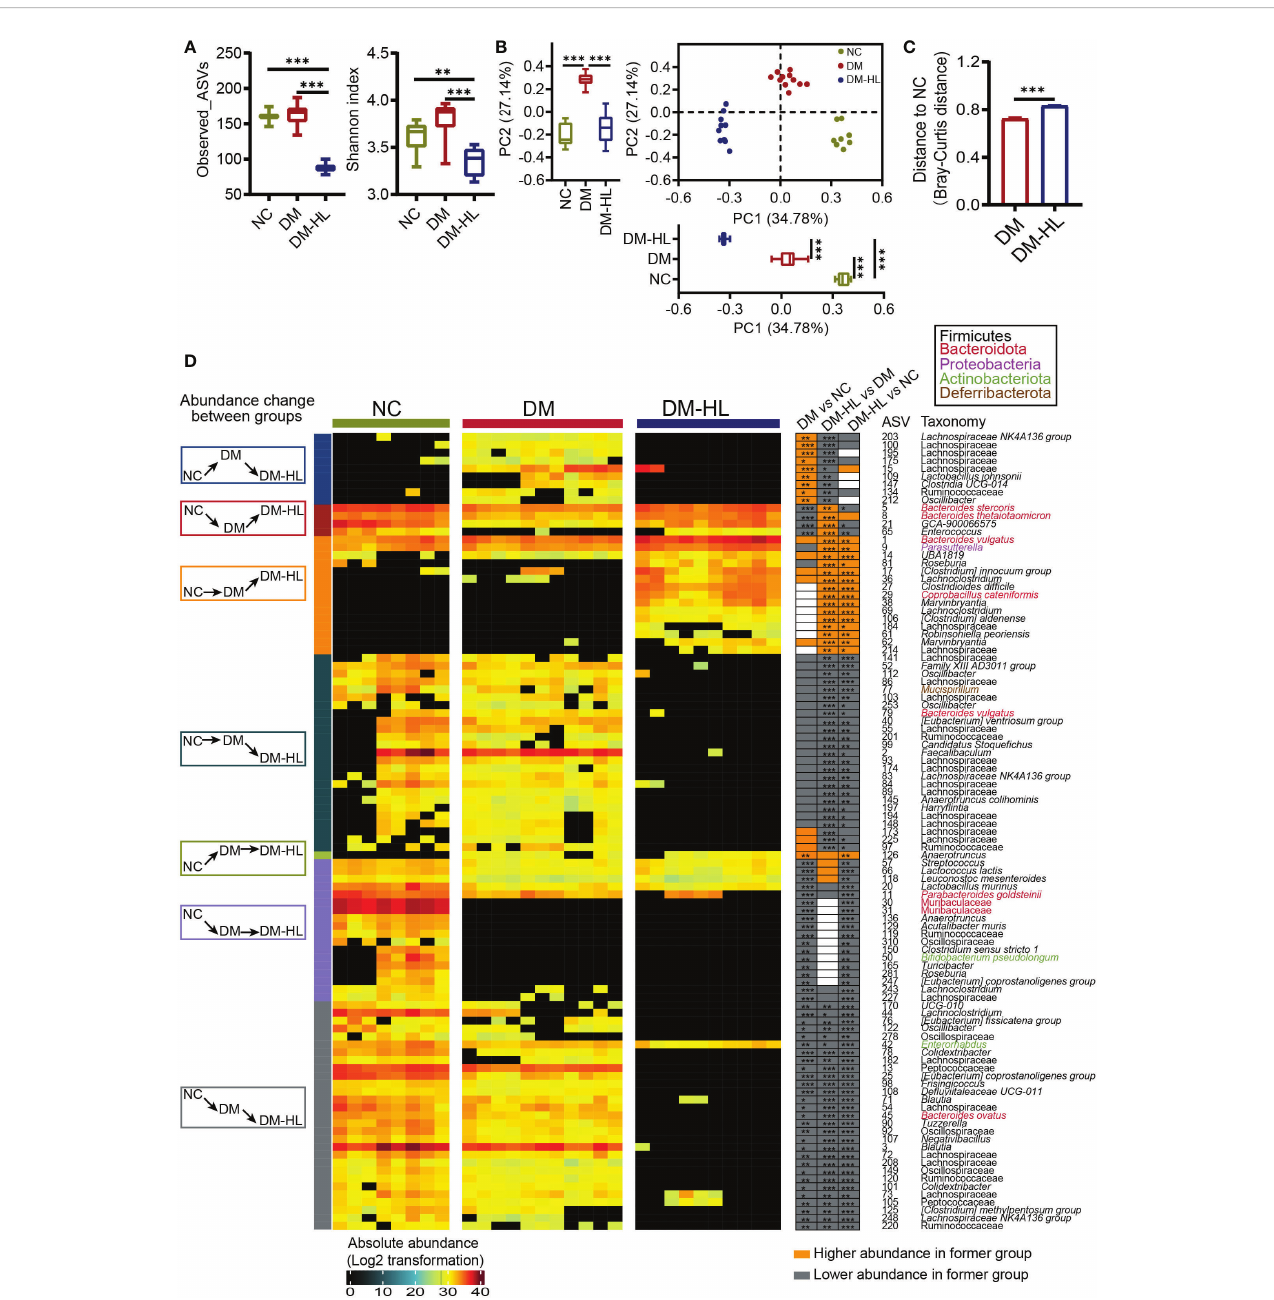
FIGURE 3 HL treatment signi fi cantly shaped a unique structure of the gut microbiota. (A) a -diversity of the gut microbiota represented as Observed_ASVs and the Shannon index. Data was shown in box plot. And the line in the middle of box is plotted at the median, the inferior and superior limits of the box correspond to the 25 th and 75 th percentiles, the whiskers correspond to maximum and minimum. Signi fi cance was analyzed using one-way ANOVA followed by Tukey ’ s post-hoc test. (B) Principal coordinate analysis (PCoA) of the gut microbiota based on the Bray-Curtis distance. The box plots showed the changes of gut microbiota among three groups on PC1 or PC2 (the line in the middle of box is plotted at the median, the inferior and superior limits of the box correspond to the 25 th and 75 th percentiles, the whiskers correspond to maximum and minimum). Signi fi cance was analyzed using one-way ANOVA followed by Tukey ’ s post-hoc test. (C) Bray-Curtis distance from the DM group and DM-HL group to the NC group. Data are presented as the mean ± SEM. Signi fi cance was analyzed using a two-tailed Mann-Whitney test. **p < 0.01, ***p < 0.001. (D) Heatmap of 101 ASVs across all samples. The color of the block corresponds to the log 2 -transformed value based on the absolute abundance of each sample. Left, several classi fi cations of the change in ASV abundance among groups; frame colors indicate speci fi c situations of change. Right, the changing direction of 101 ASVs through pairwise comparison of groups analyzed by the two-tailed Mann-Whitney test. Orange indicates that ASV abundance was higher in the latter group, and the grey indicates that ASV abundance was lower in the former